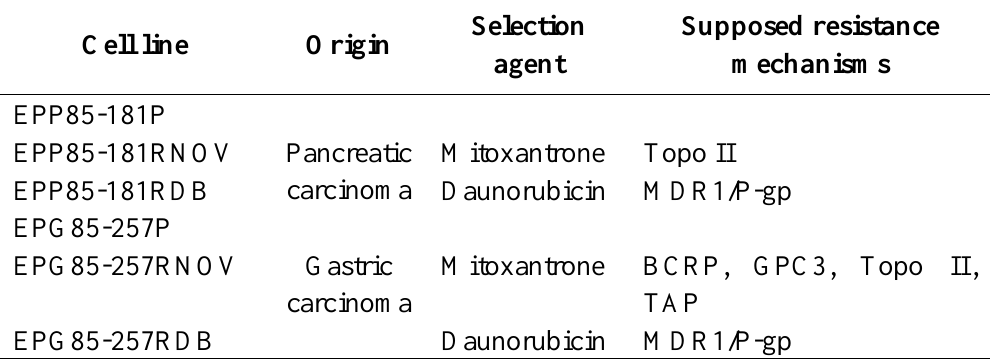
Table 2. Cancer cell lines with drug-resistant